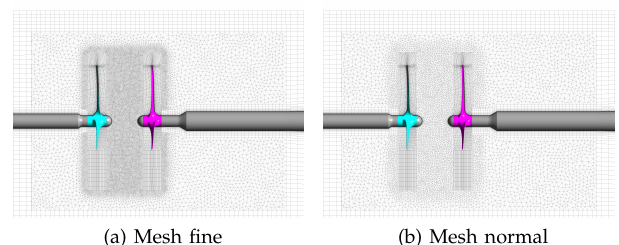
Fig. 4. Additional meshes for mesh study of near field with smaller refinement area around the turbines.